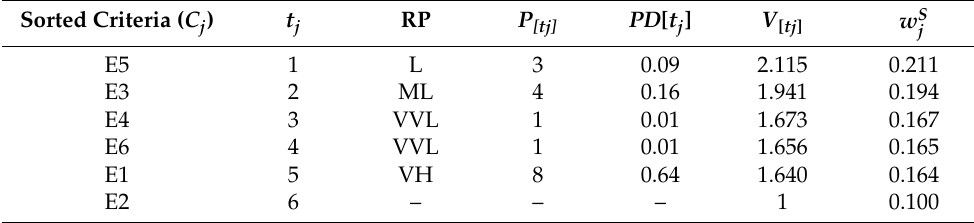
Table 6. Calculations of the subjective weights of bank efficiency criteria.